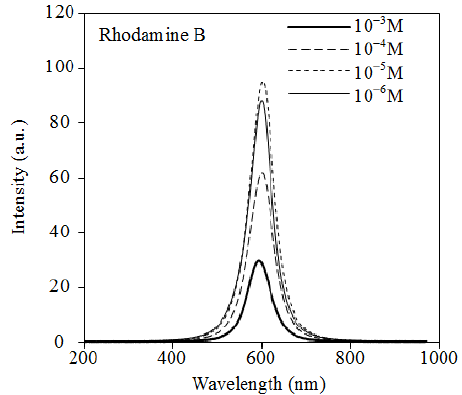
Fig. 1 Fluorescence spectra of RB dye dissolved in ethanol recorded at different concentrations.